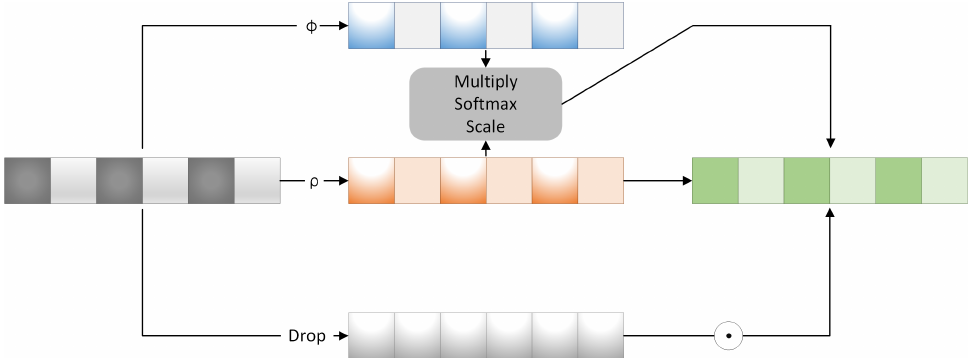
Figure 7. The detail of the spatio-attention